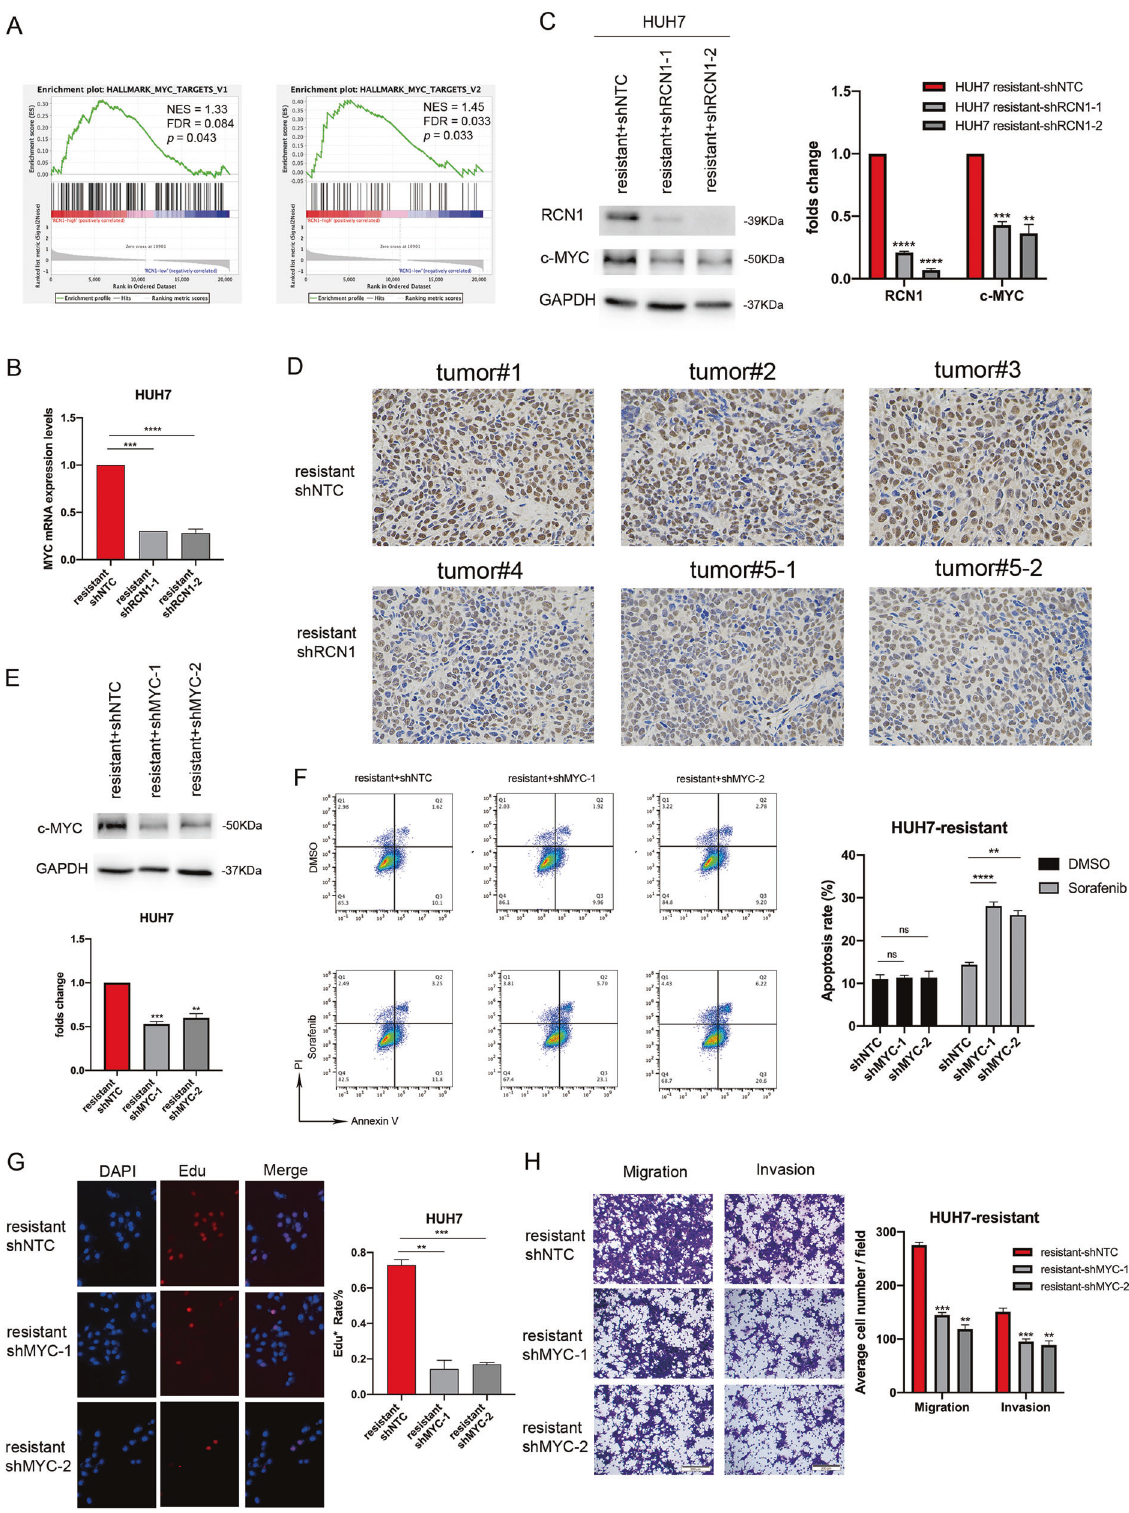
Fig. 6 RCN1 activates c-MYC signaling in sorafenib-resistant cells. A Signaling pathways affected by RCN1, analyzed using GSEA based on TCGA data. B mRNA levels of MYC in RCN1-knockdown sorafenib-resistant cells. C Western blot analysis showing protein levels of RCN1 and c-MYC in sorafenib-resistant Huh7 cells with or without RCN1 repression. D Intensity of c-MYC immunohistochemical staining in xenograft tumor sections. E Knockdown ef fi ciency of MYC analyzed using western blot. F Apoptosis of sorafenib-resistant Huh7 cells with MYC knockdown in the presence of 5 μ M sorafenib analyzed using fl ow cytometry. G Cell proliferation in sorafenib-resistant Huh7 cells with MYC knockdown assessed using an EdU assays. H Transwell assays of cell migration and invasion in sorafenib-resistant Huh7 cells after MYC knockdown. Data are presented as the means ± SEM of three independent experiments; data for western blot have undergone quantitative analysis. ns not signi fi cantly different. ** P < 0.01; *** P < 0.001; **** P < 0.0001, t -test. Cell Death Discovery (2021)